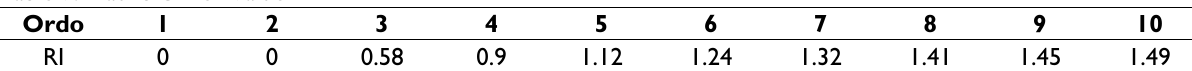
Table 9: Matric Order Value Ordo